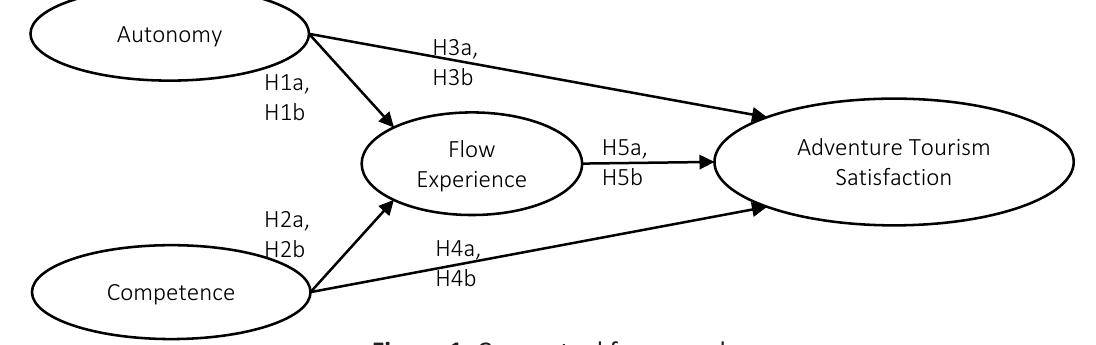
Figure 1. Conceptual